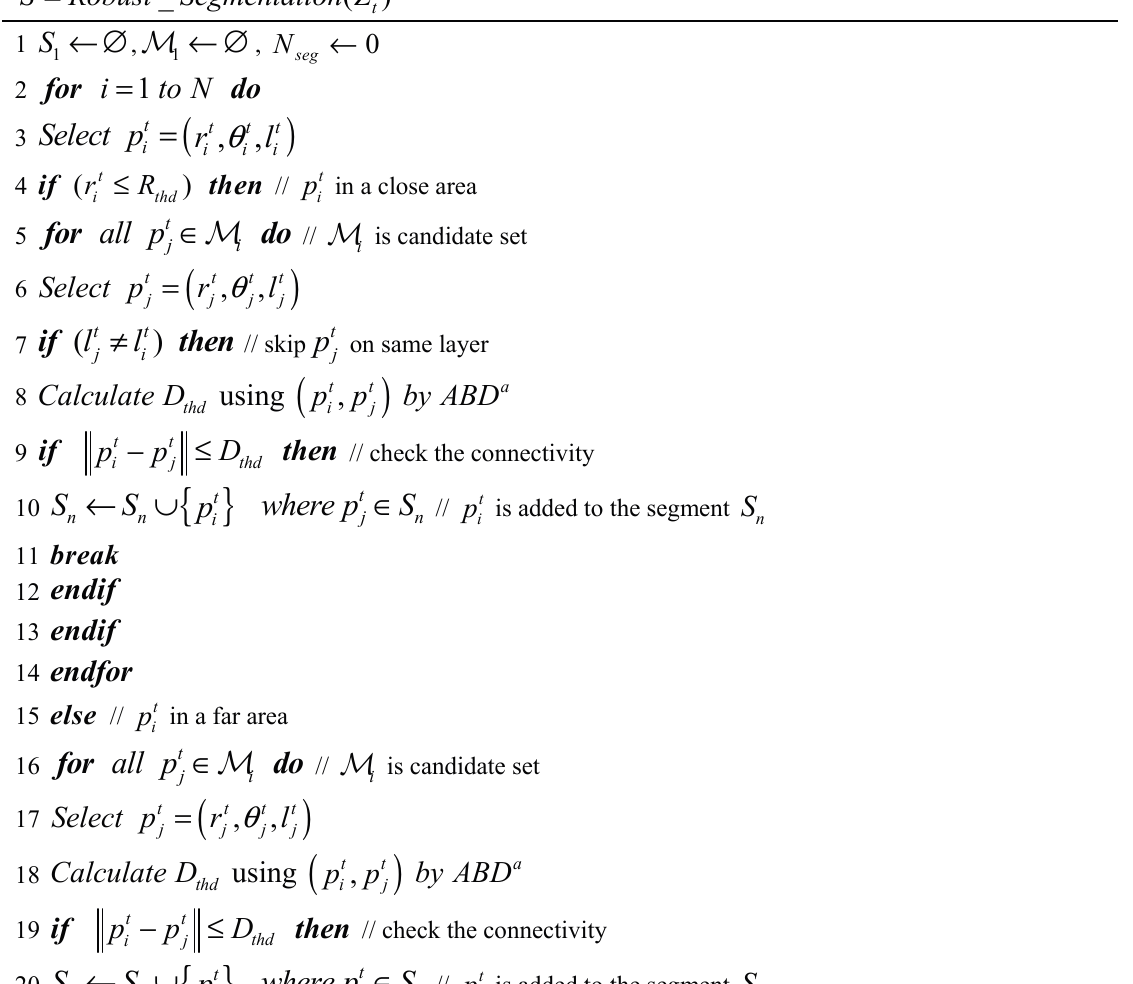
Table 2. Pseudo-Code of Robust Segmentation through Ghost